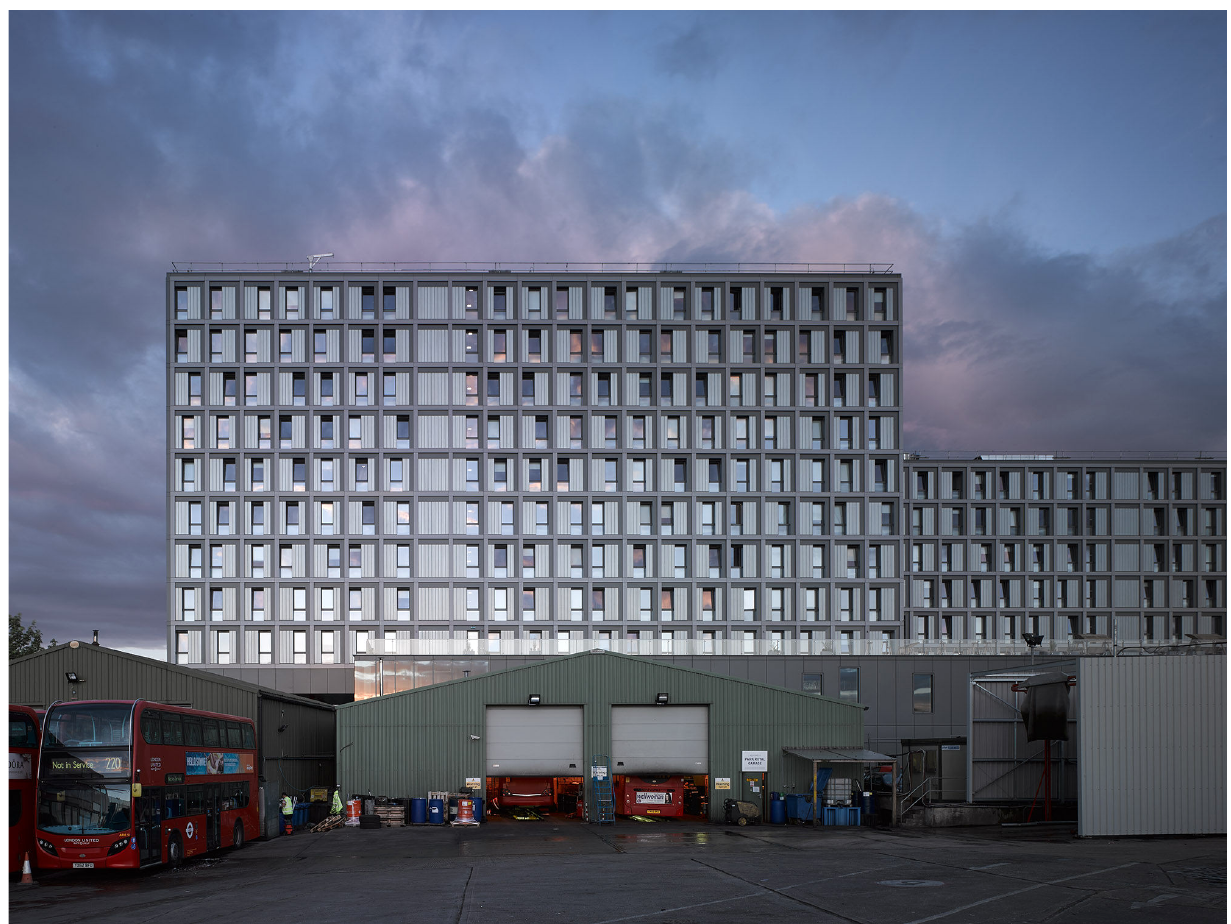
Figure 2. The Collective Old Oak, London. Source: Courtesy of Nick